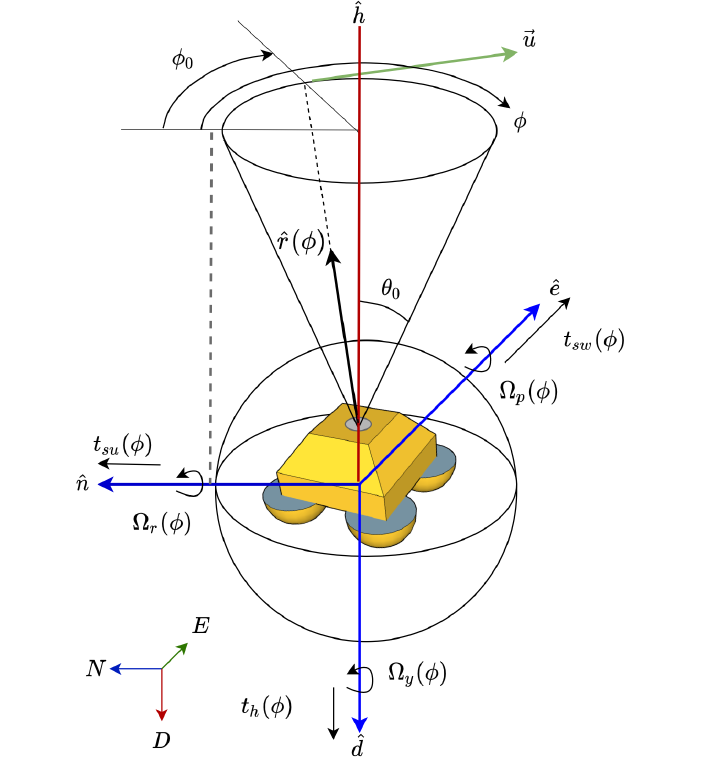
Figure 1. The motion geometry of the FDWL